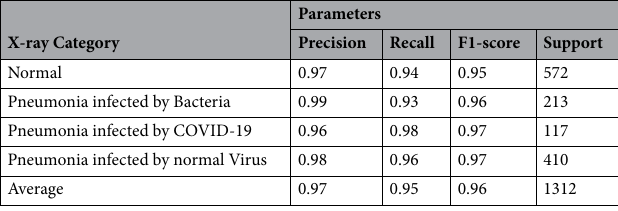
Table 2. Experimental results for test database.